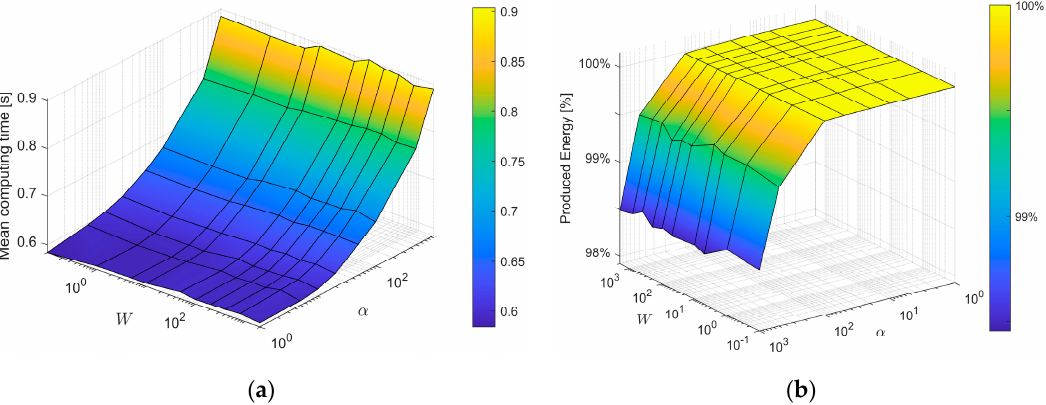
Figure 18. DoE with variable cost function weights: ( a ) Average computing time in function of the varied parameters; ( b ) produced energy in function of the varied parameters.